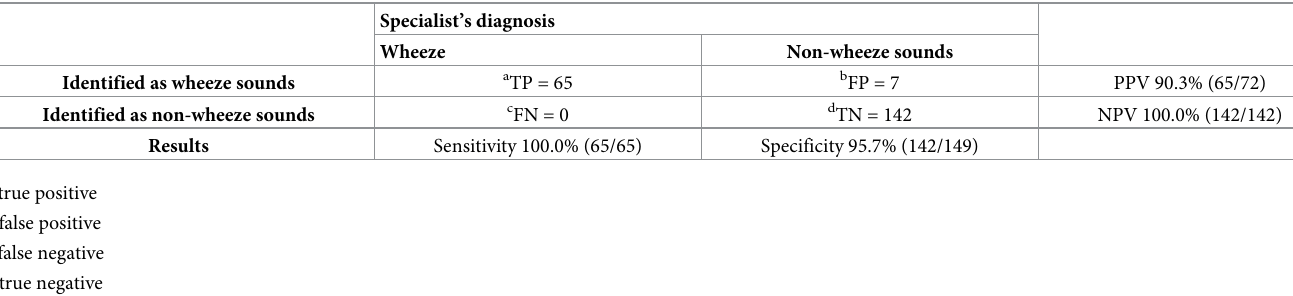
Table 4. Results per file obtained using the newly developed wheeze recognition algorithm for children.